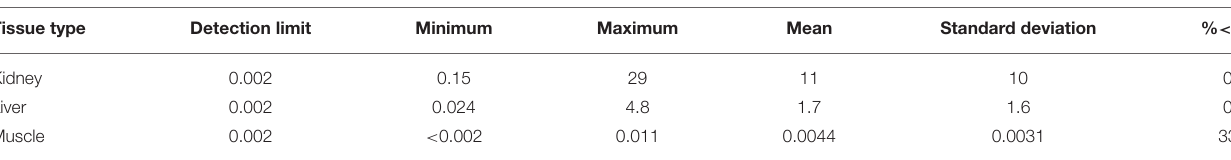
TABLE 6 | SRFN Summary Statistics ( n = 15).